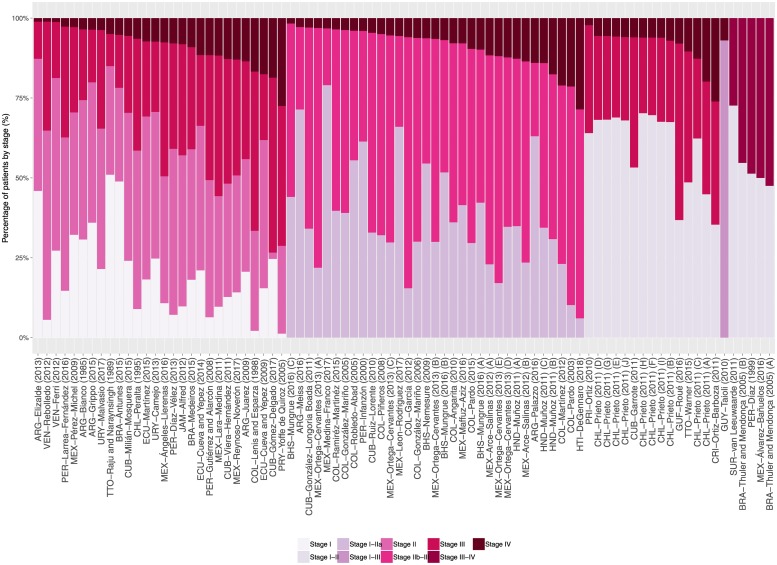
Study-specific percentage of patients by stage at presentation.Percentage of T3/T4 cancers were used as proxy of stages III/IV for SUR-van Leeuwaarde (2011). Localized, regional and distant disease were considered as stages I-II, III and IV for CRI-Ortiz-Barboza (2011), CUB-Garrote (2011), and PRI-Ortiz (2010). Recruitment or diagnosis years: BHS-Mungrue (2016) A→C = 2009→2011; BRA-Thuler and Mendonça (2005) A = 1990–1994 B = 1995–2002; CHL-Prieto (2011) A→J = 2000→2011; HND-Muñoz (2011) A = 1999 B = 2000–2004 C = 2005–2009; MEX-Ortega-Cervantes (2013) A→E = 2006→2010; MEX-Arce-Salinas (2012) A = 2008 B = 2009. Study references are given in the Supporting Information (S3 File).